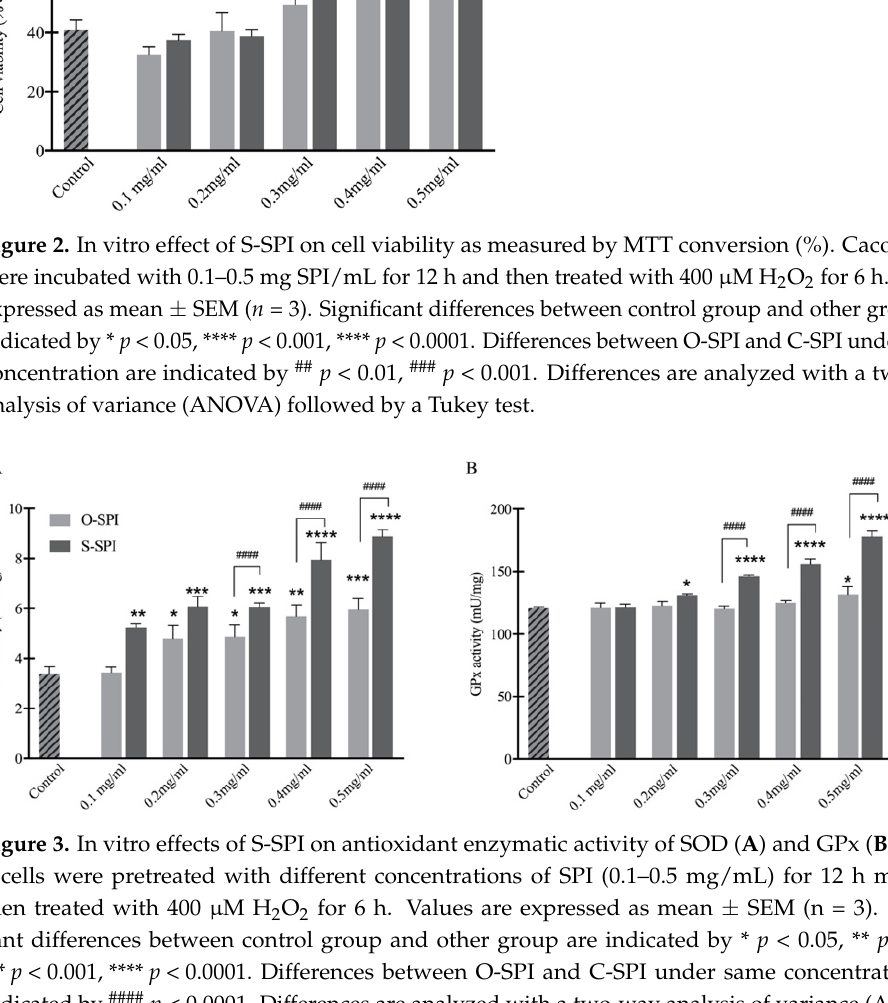
Figure 2. In vitro effect of S-SPI on cell viability as measured by MTT conversion (%). Caco-2 cells were incubated with 0.1–0.5 mg SPI/mL for 12 h and then treated with 400 μ M H 2 O 2 for 6 h. Values expressed as mean ± SEM (n = 3). Significant differences between control group and other group are indicated by * p < 0.05, **** p < 0.001, **** p < 0.0001. Differences between O-SPI and C-SPI under same concentration are indicated by ## p < 0 .01, ### p < 0 .001. Differences are analyzed with a two- way analysis of variance (ANOVA) followed by a Tukey test.